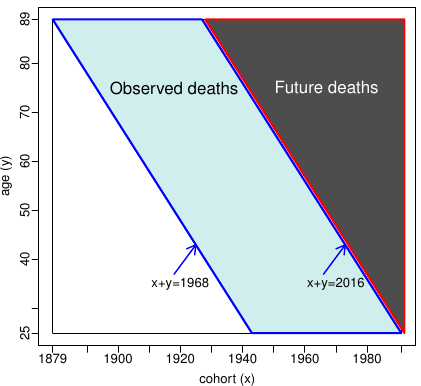
Figure 1. Support of the observations and forecast